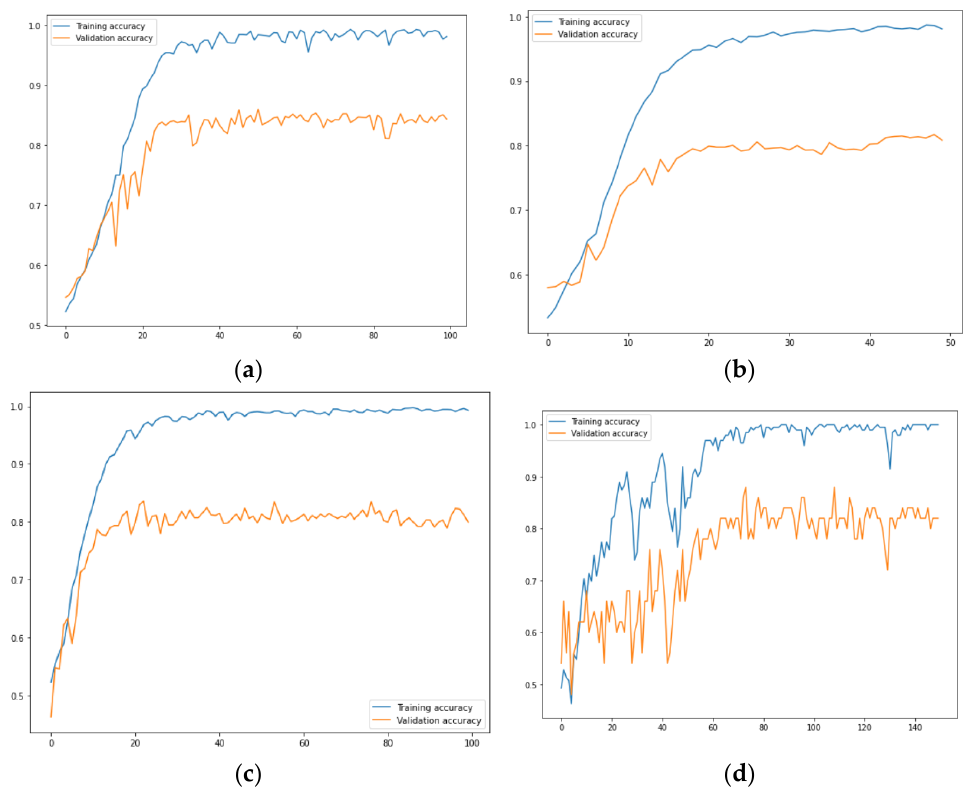
Figure 9. ( a ) Training vs. validation accuracy for channel 1, for model 2, where window = 10 s. ( b ) Training vs. validation accuracy for channel 1, for model 1, where window = 10 s. ( c ) Training vs. validation accuracy for channel 6, for model 2, where window = 30 s. ( d ) Training vs. validation accuracy for channel 5, for model 2, where window = 30 s.